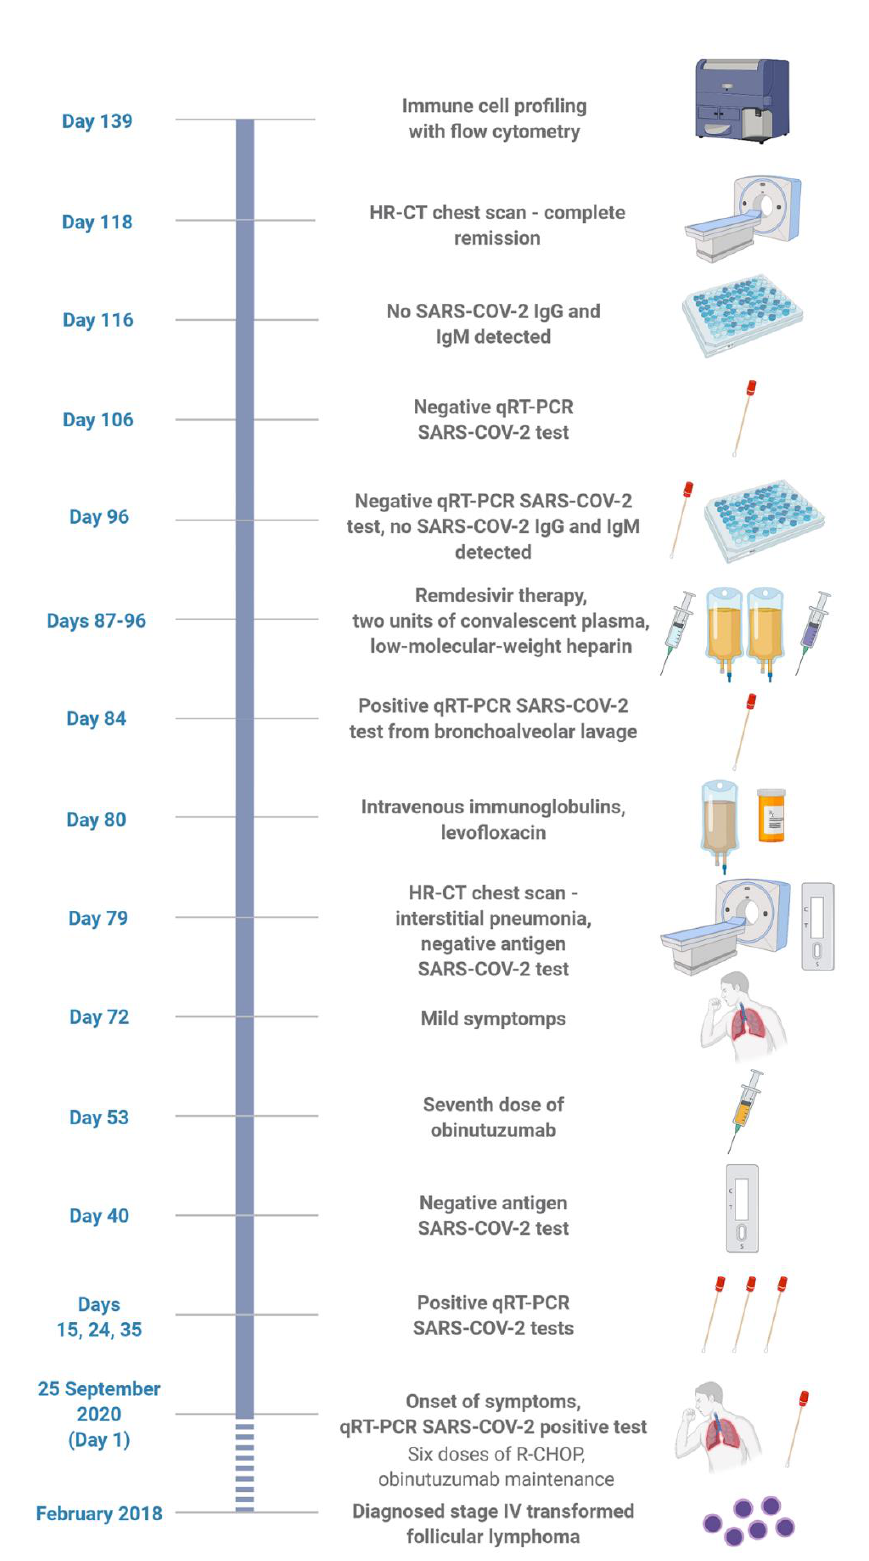
Figure 1. Clinical timeline (until day 139 after diagnosis of COVID-19). The figure was performed with BioRender (Toronto, ON, Canada) graphical software.